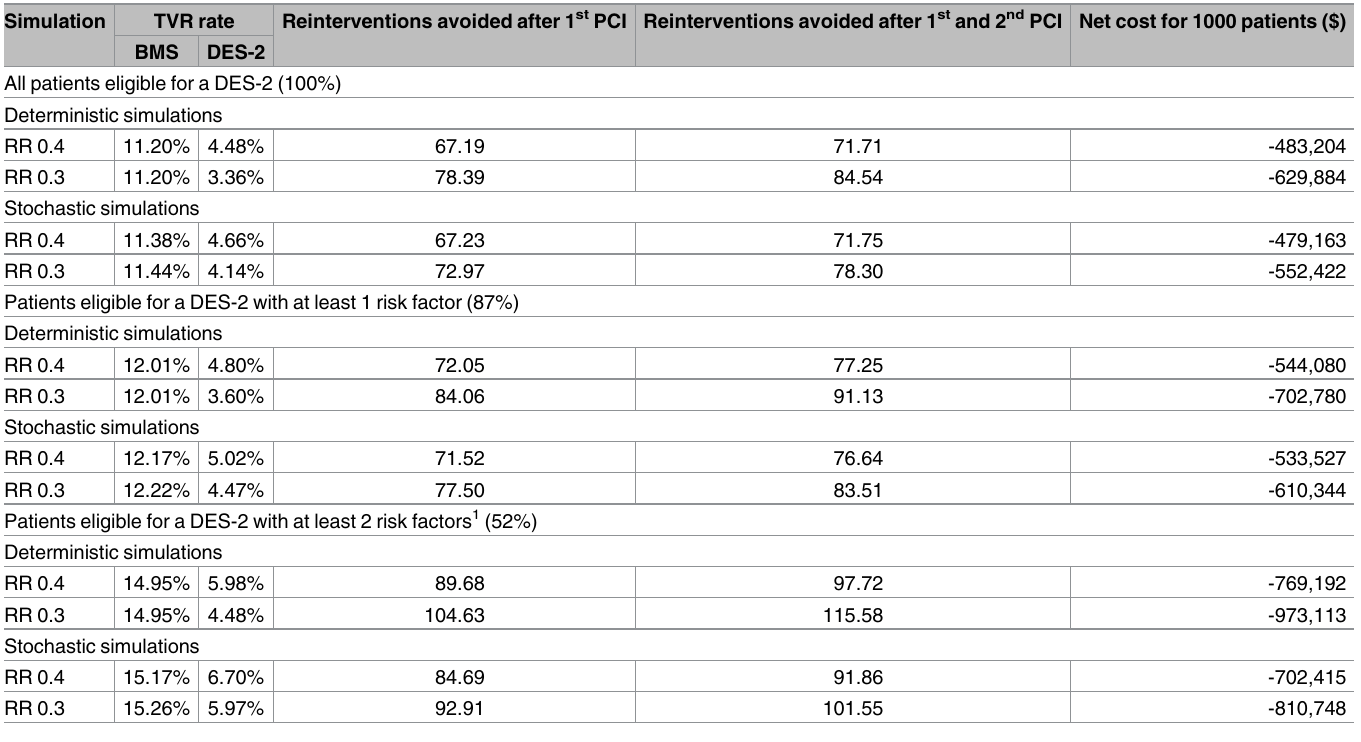
Table 7. Cost–benefit simulations over 2 yearsfor 1000